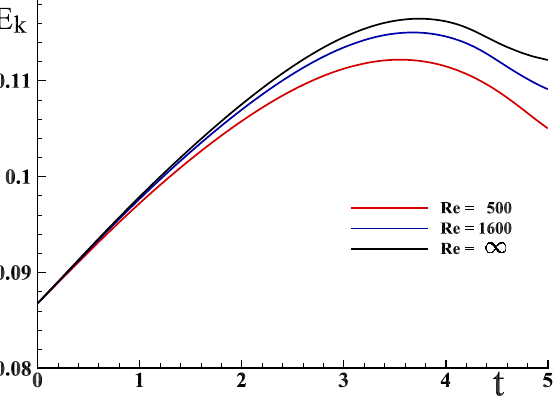
Figure 10. The evolution of the kinetic energy E k corresponding to the Taylor–Green vortex case shows a similar behavior at Reynolds numbers of Re = 500,1600 and for an inviscid